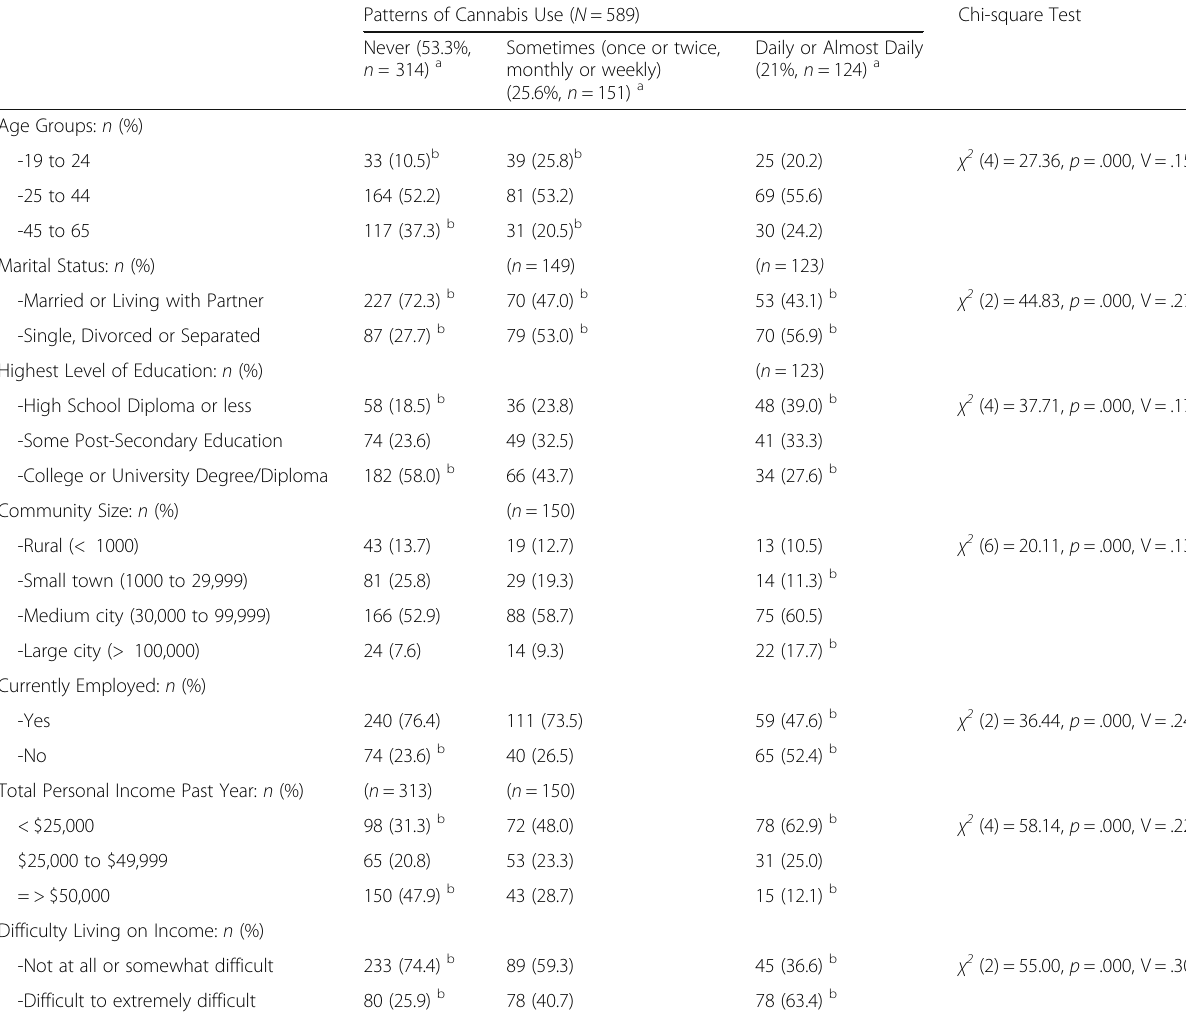
Table 1 Patterns of cannabis use in past year by socio-demographic indicators for the total sample ( N = 589) Patterns of Cannabis Use ( N = 589) Chi-square Test Never (53.3%, n = 314)